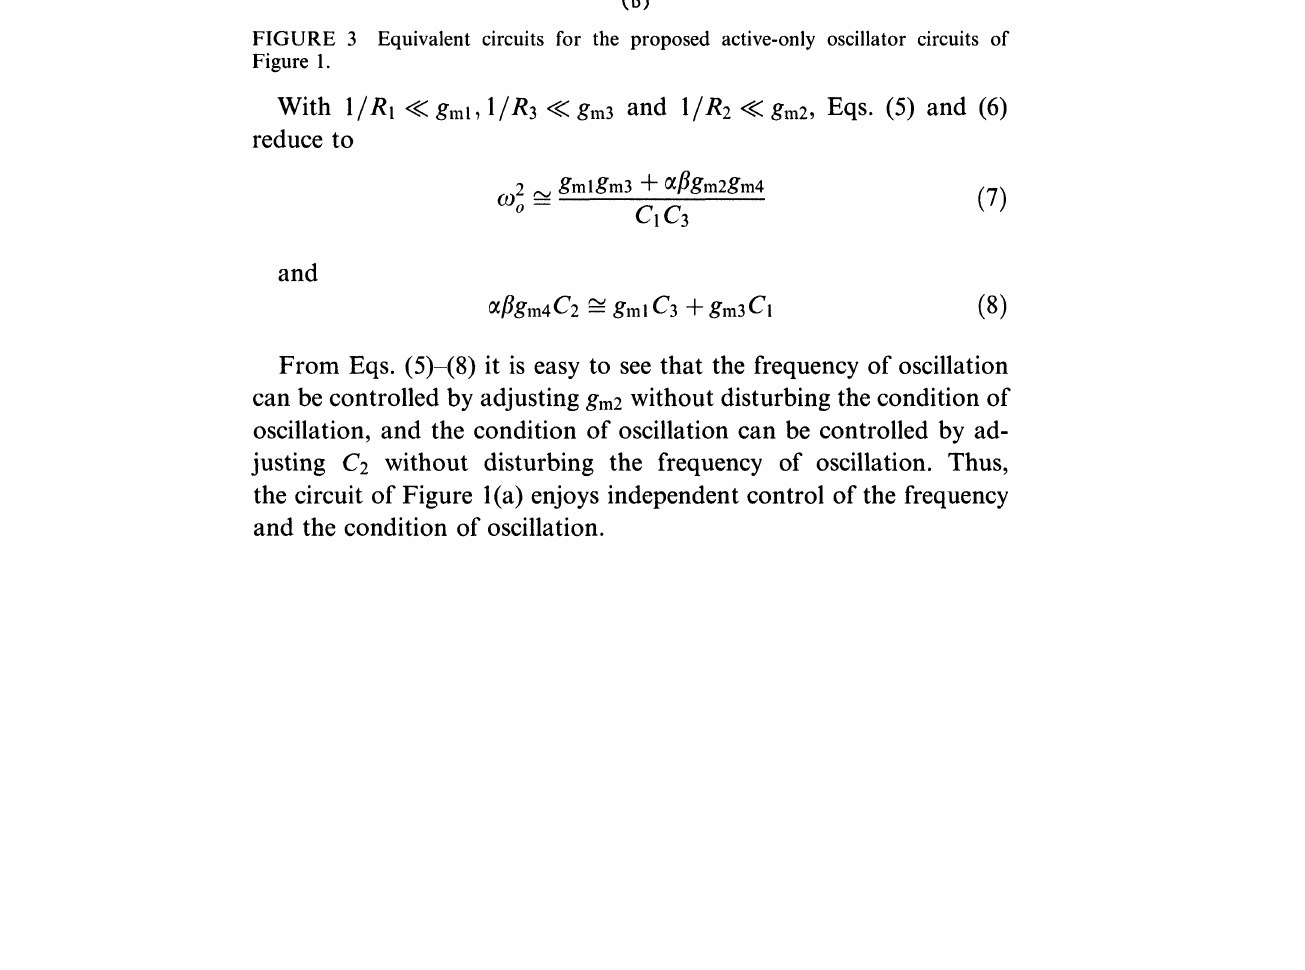
FIGURE 3 Equivalent circuits for the proposed active-only oscillator circuits of Figure